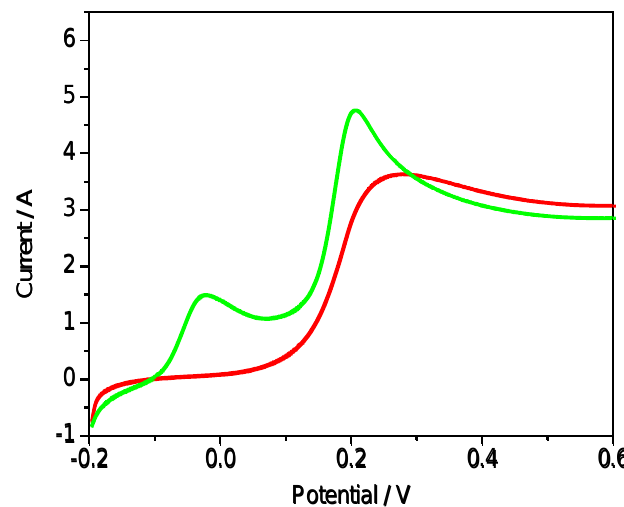
Figure 6. Linear sweep voltammetry of preload PAAm (red) and NanoC (green) from a mixture containing AA (1 mM) and DA (1 mM) in PBS (pH 7). Scan rate: 1 mV/s.